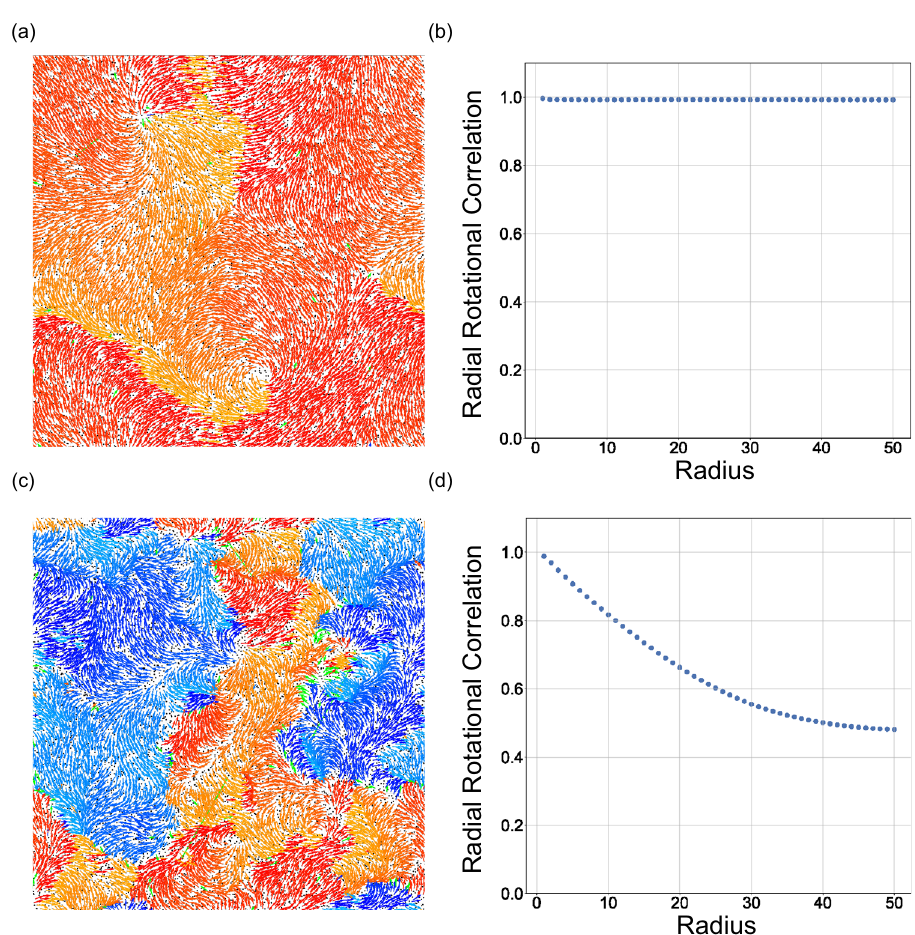
Fig. 5 Radial rotational correlations. Visualising and quantifying the range of correlations in the rotational state of the individual active particles. Yellow to red colours indicate particles rotating anticlockwise, while light to blue colours correspond to clockwise rotations. Although the direction of the momentary velocities spreads over 360°, the direction of rotation is the same everywhere in panel ( a ), and it is in both directions in panel ( c ). Panels b and d display the level to which rotations are correlated. Values close to 1 (as in panel ( b )) indicate that the probability that two particles being at a distance within 50 lattice units rotating in the same direction is close to one, i.e., the rotations are fully correlated over the region considered. The decaying feature of the rotational correlations in panel ( d ) is due to the fact that (1) there are both clockwise and anticlockwise extended regions in the system for this set of the parameter values as well as due to (2) taking a time average over the con fi gurations in a long run of the corresponding simulations. The results are for 100 x 100 runs with parameters the same as in Table